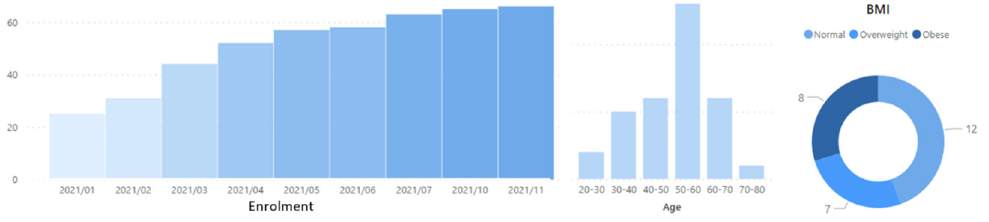
Figure 2. Enrolment of patients in the first year of the study and their age and body mass index distribution.